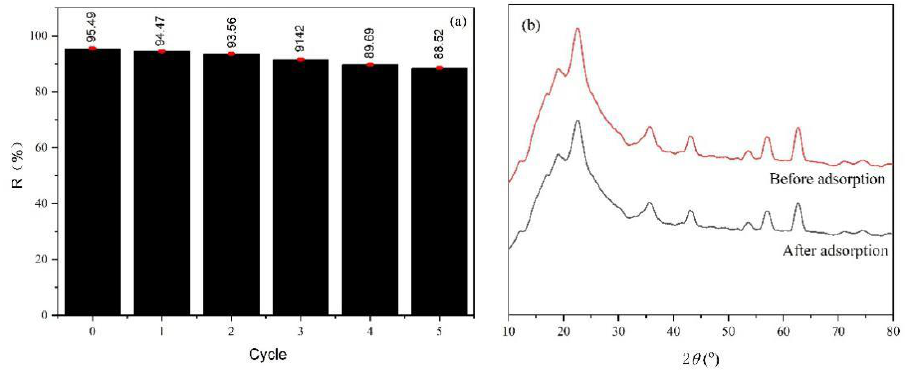
Figure 6. Reusability of CFS for CAPC adsorption ( a ) and XRD patterns ( b ) before and after adsorp- tion of CFS adsorbent (Adsorption time = 3 h, C 0 = 150 mg/L, V= 20 mL, m =30 mg, pH = 6.5).